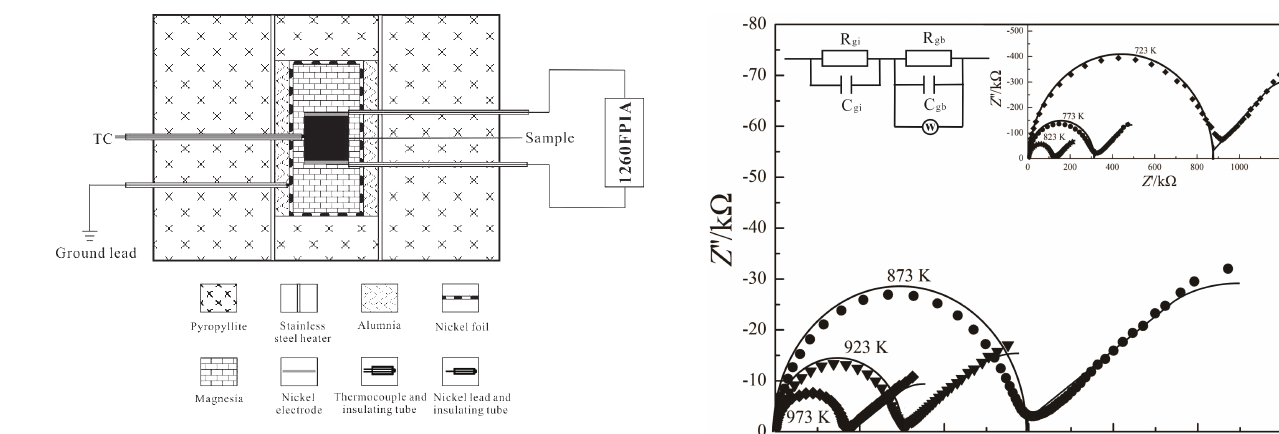
Figure 1. Experimental setup of electrical conductivity measure- ments.